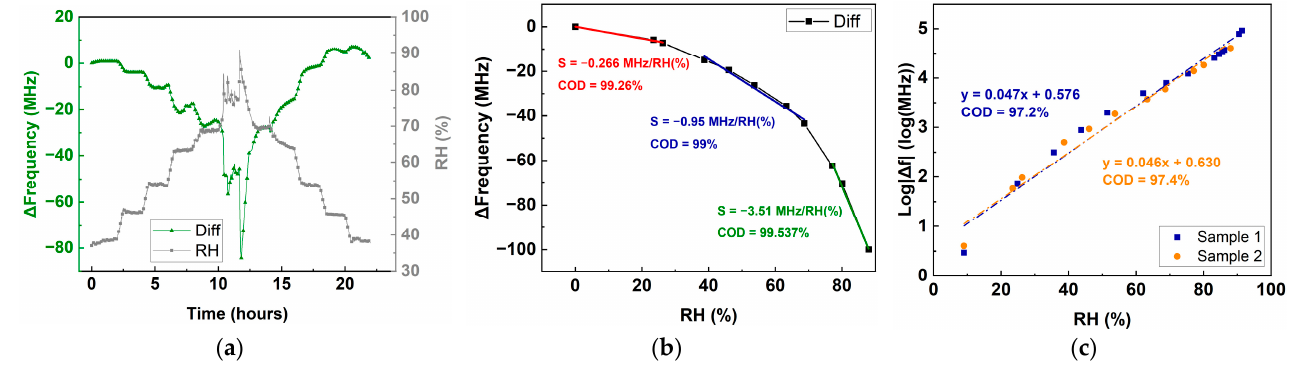
Figure 8. Sample 2 RH characterisation: ( a ) dynamic frequency response in the range 35%–75% RH, ( b ) RH calibration curve with its different sensitivities and CODs and ( c ) steady-state frequency response to RH and comparison with sample 1.